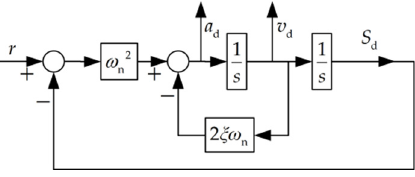
Figure 4. Second ‐ order dynamic system for reference trajectory generation. Figure 4. Second-order dynamic system for reference trajectory